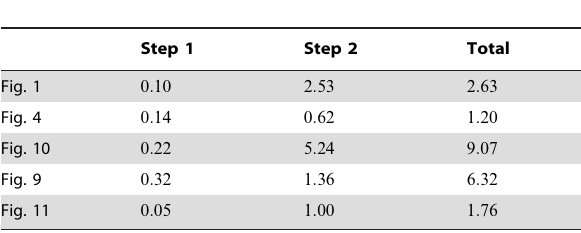
Table 2. Computational times for step 1 and step 2.